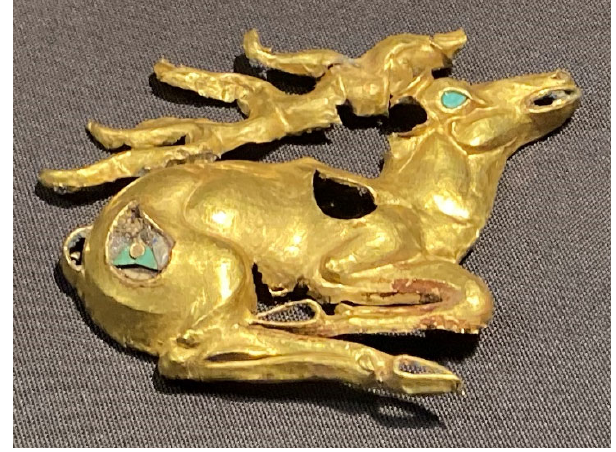
Figure 5. Recumbent stag plaque (EKRM inv. no. K П O93 ‐ 38625); gold with turquoise and lapis lazuli inlays; Kurgan 4, group II, Eleke Sazy, Tarbagatai mountains, Kazakhstan; 8th to 6th century BC. [Author’s image].